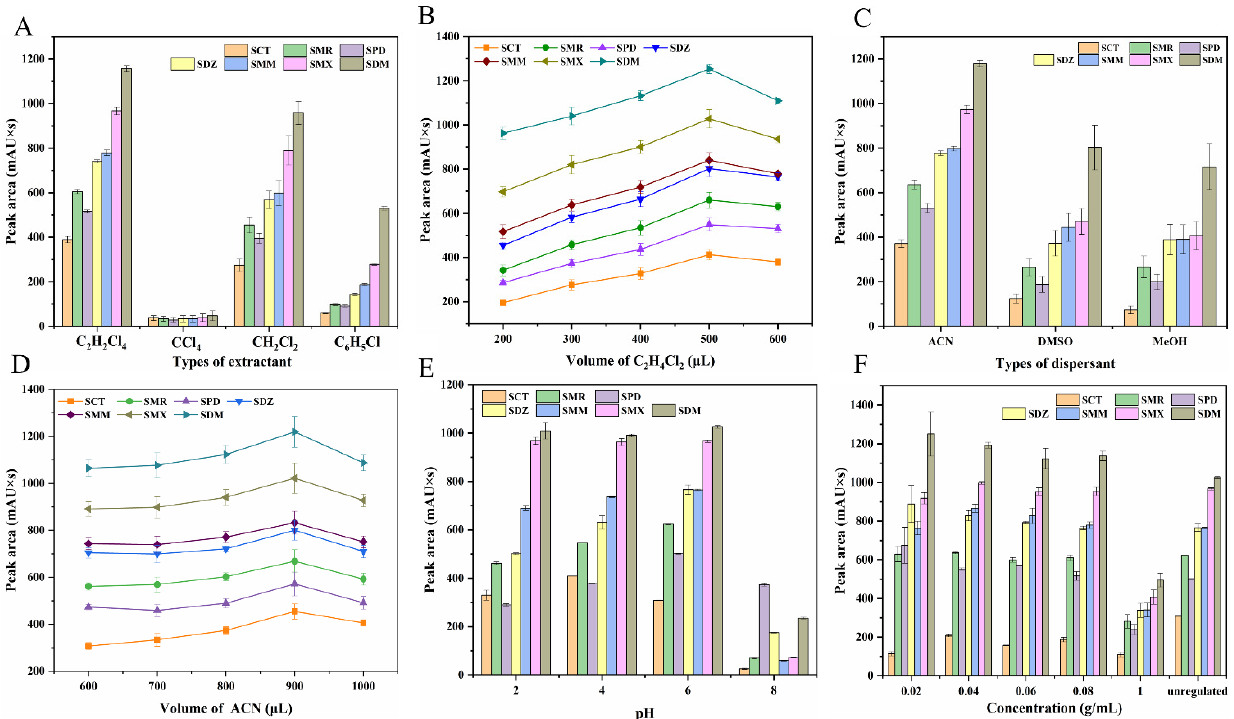
Figure 2. Effect of ( A ) types of extractants, ( B ) volume of C 2 H 2 Cl 4 , ( C ) types of dispersants, ( D ) vol- ume of ACN, ( E ) pH, and ( F ) concentration of salt on the peak areas of the seven SAs. The error bar was attained from n = 5. Other DLLME conditions: sample solution: 5 mL; ultrasound time: 5 min; centrifuge time: 8 min; centrifuge rate: 8000 rpm.